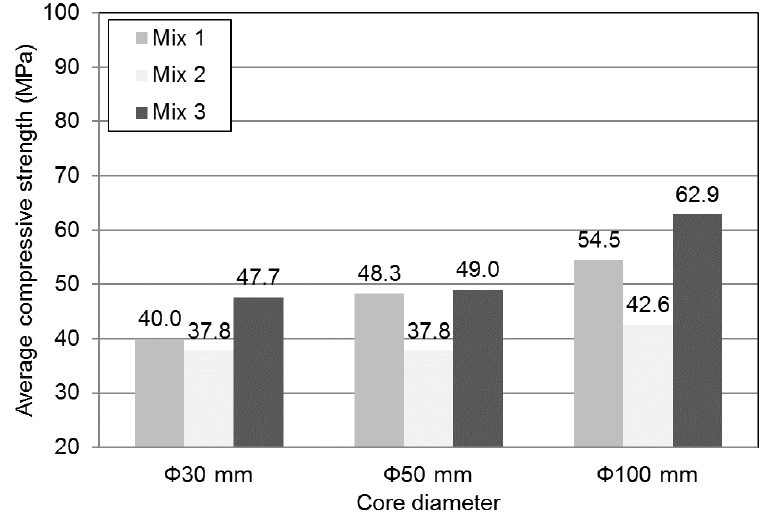
Figure 9. Compressive strength of concrete according to the diameters of 30, 50, 100 mm.